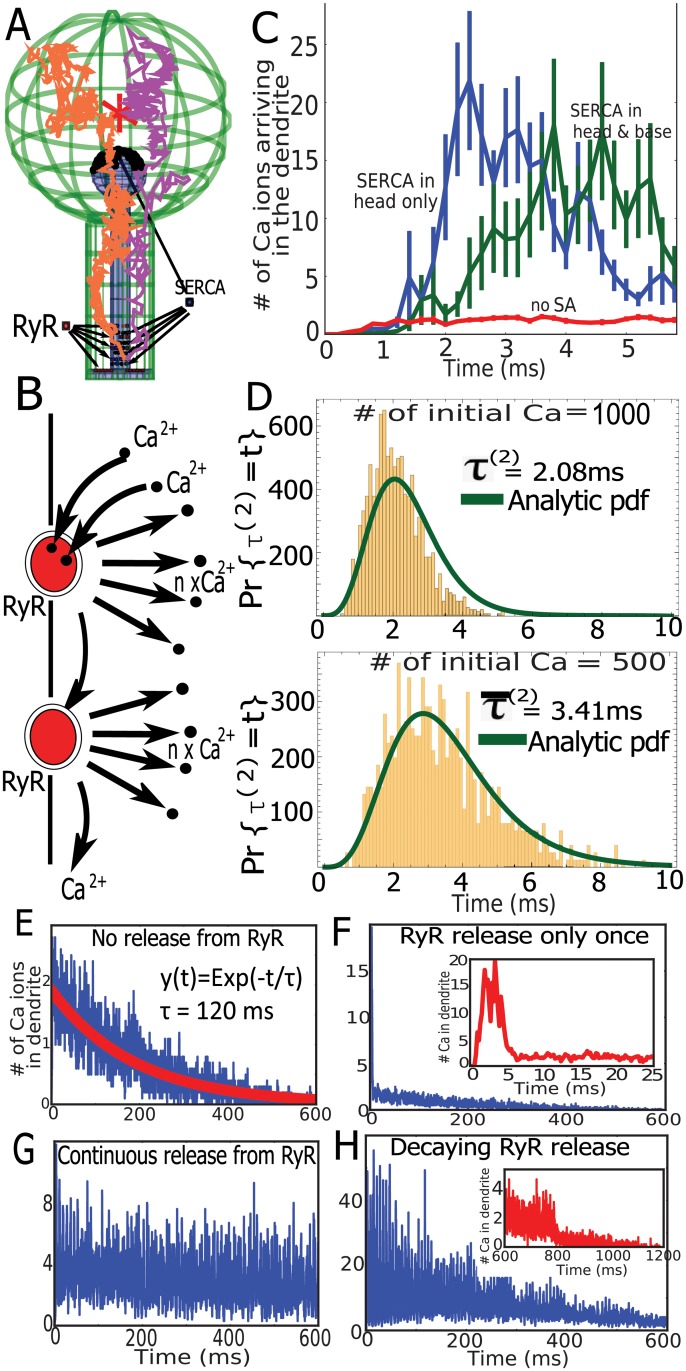
Mechanism of fast calcium release triggered by RyRs.(A) Representation of calcium trajectories in a spine with ER, in which SERCA (blue) are in the head and at the base. Arrangement in four separated layers containing nine of them. RyRs arrangement is described in Fig 3H. (B) Schematic release of calcium ions from RyR opening, triggered by two calcium ions. (C) Dynamics of calcium accumulation in the dendrite in the presence (green) or absence (blue) of SERCA pumps at the base versus dynamics in a spine with no SA (red). (D) Arrival times of the two fastest calcium ions that open the first RyR when the initial numbers are N = 1,000 and N = 500, superimposed with the analytical solution (not a fit) of Eq 5 (see S1 Text). (E) Transient calcium ions arriving at the base of the dendrite when no RyRs are present but with SERCA and calcium pumps. (F) Similar to (G), all RyRs open and release calcium ions only once and then are deactivated (magnified in the inset). (G) Continuous calcium release following two bound ions at RyR (with a refractory period of 6 ms). (H) Same dynamics as in (G), but the number of calcium released from RyRs is reduced exponentially with time; when RyRs open, nCa ions are released and the receptor is desensitized for 6 ms. Initially, nCa = 8 and decreases exponentially with a time constant of 360 ms. ER, endoplasmic reticulum; RyR, Ryanodyne receptor; SA, spine apparatus; SERCA, sarco/ER calcium-ATPase.